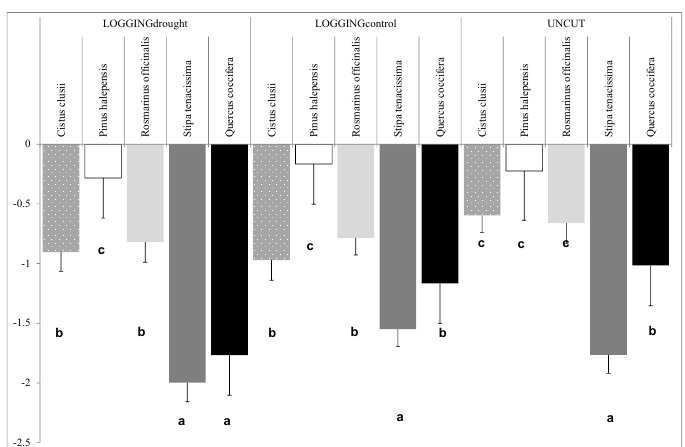
Figure 2. Predawn leaf water potential ( Ψ PD , MPa) after the drought period 2 years after the fire (autumn 2011), with post-fire management and species as significant factors. Letters indicate significant differences between species within treatments by using Tukey’s HSD and p -value <